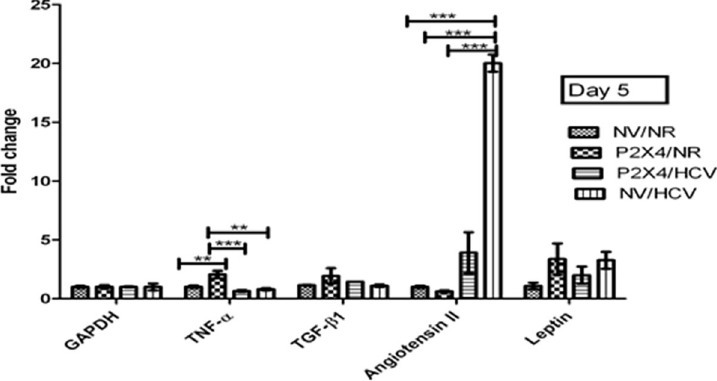
Fig 15. Expression of various cytokines on day 5 of post infection. All values are expressed as mean ± SEM, � P � 0.05 vs. control NV/HCV.